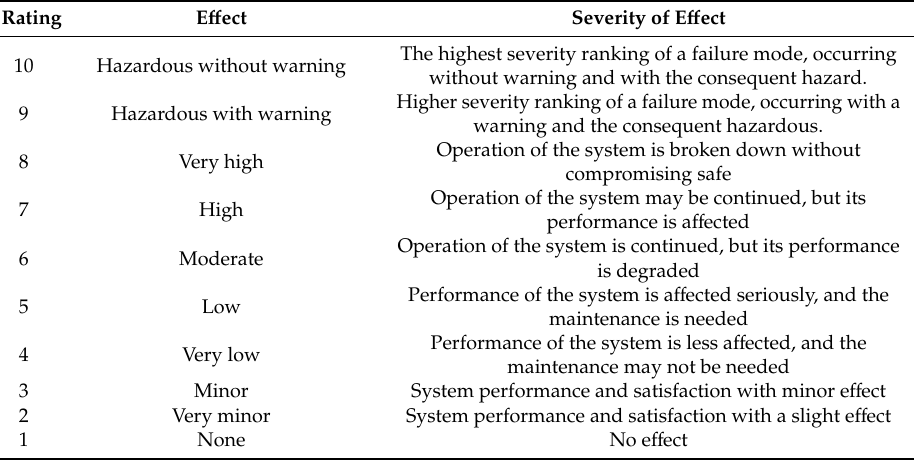
Table 2. Traditional ratings for failure mode’s severity (SEV) [17].